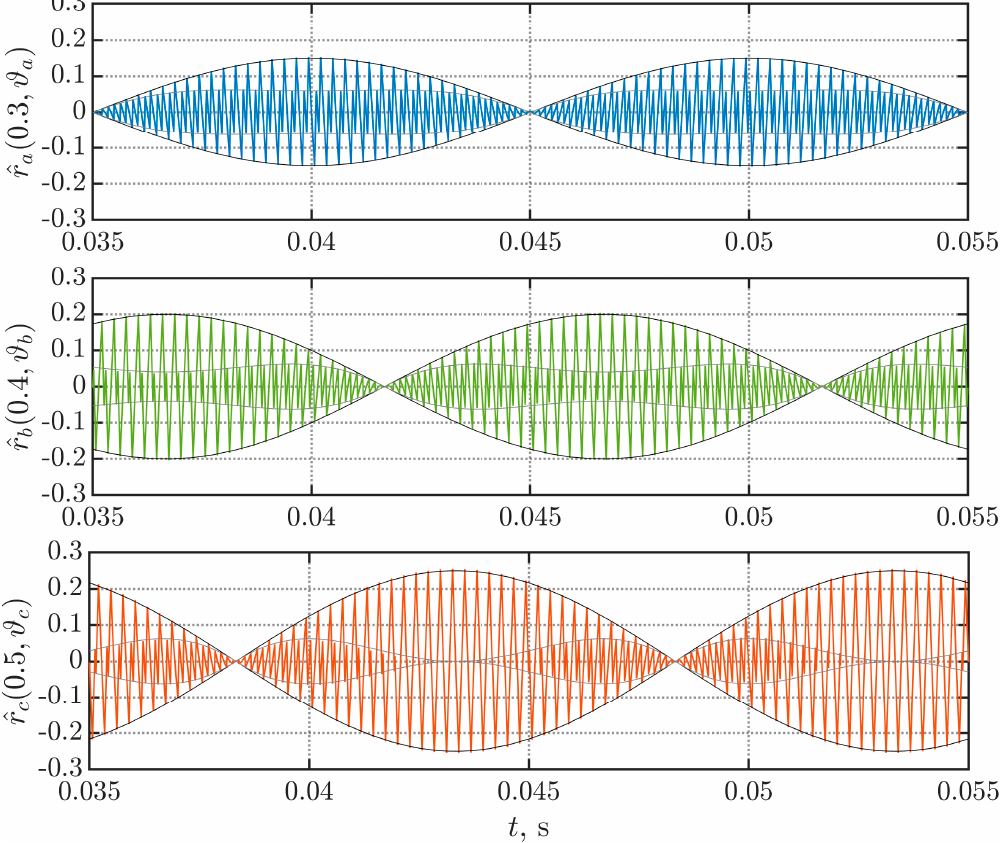
Figure 5. Normalized phase current ripples in case of modulation index unbalance ( m a = 0.3, m b = 0.4, m c = 0.5) with primary (black) and secondary (gray) envelopes for sinusoidal PWM.